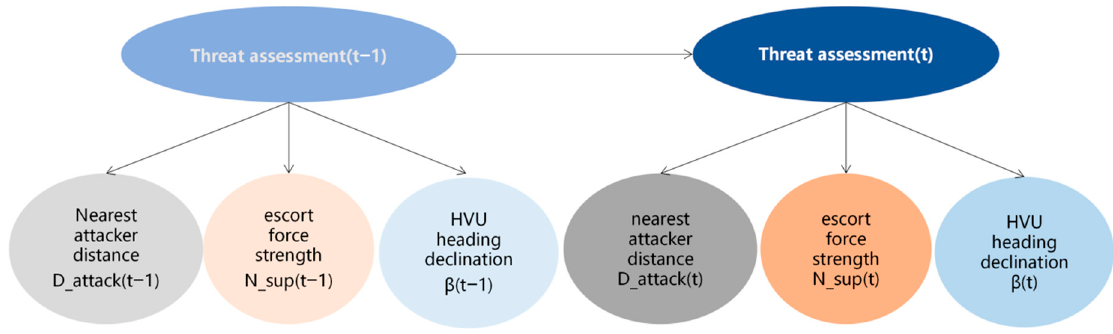
Figure 3. HVU threat assessment model based on Dynamic Bayesian Network.